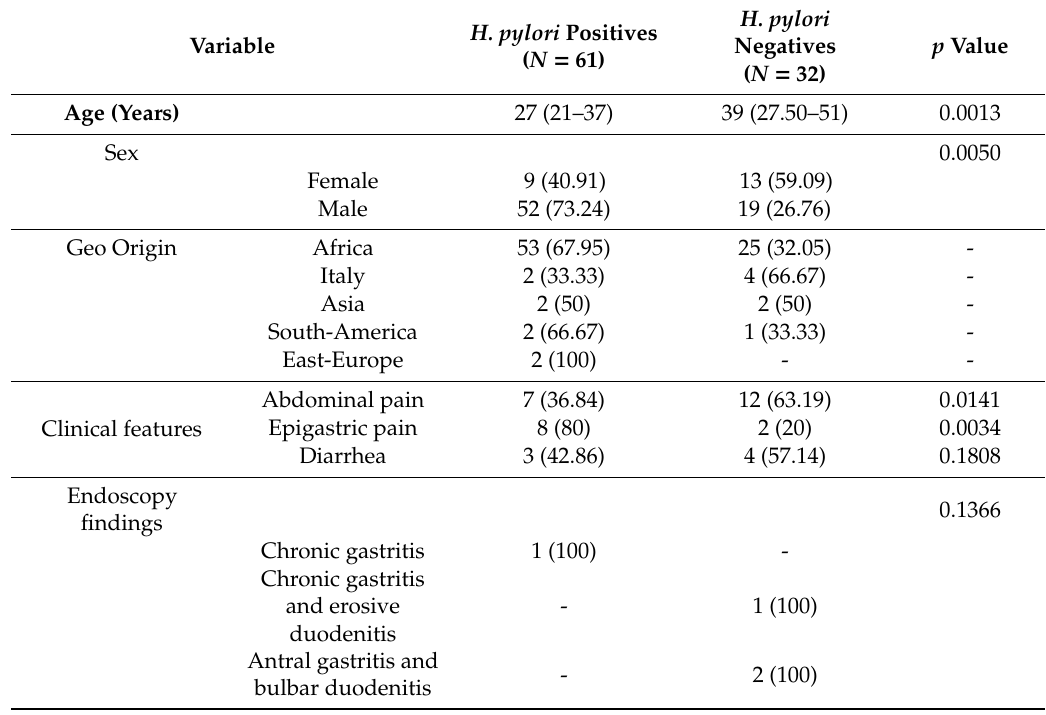
Table 2. Baseline characteristics of the screened subjects (N = 93) between the two groups H. pylori positive and negatives. Categorical and continuous variables are presented as numbers (%) and medians (interquartile range),